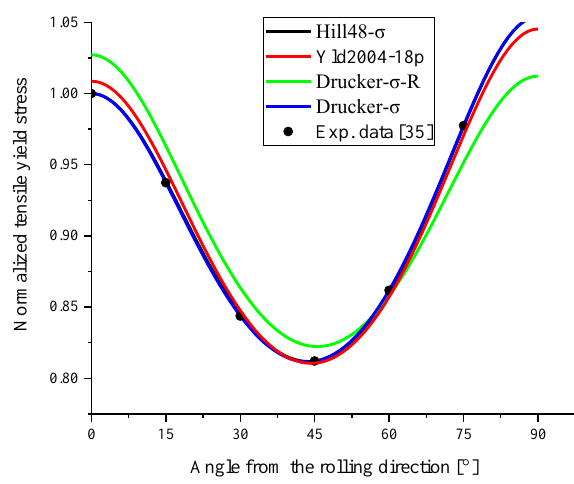
tensile/compressive yield stresses and r-values for several yield criteria, respectively. The yield stress